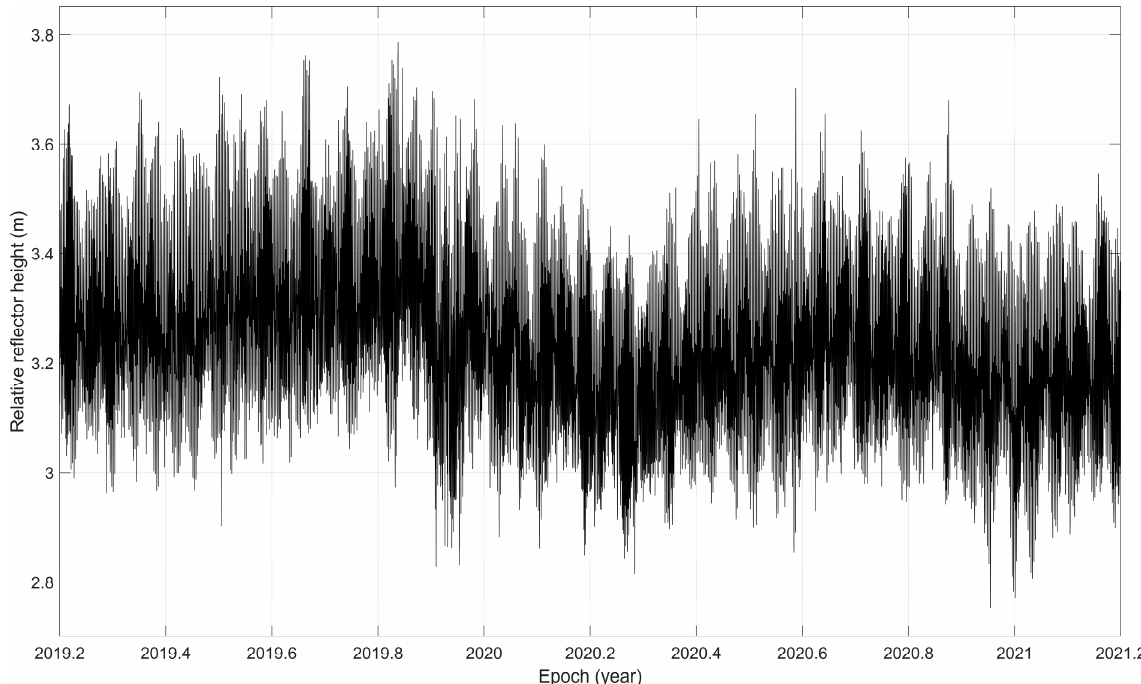
Figure 4. Relative reflector height retrieved by GNSS-R at Port-au-Prince tide gauge station.